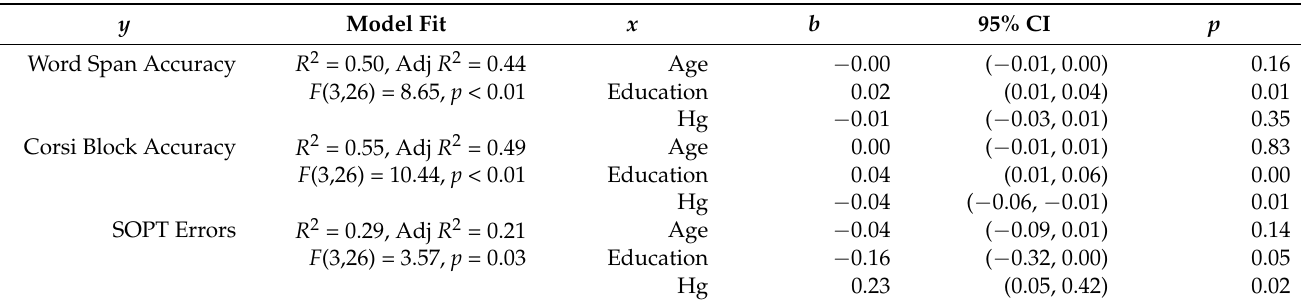
Table 4. Multiple Linear Regression Models for Working Memory Components and